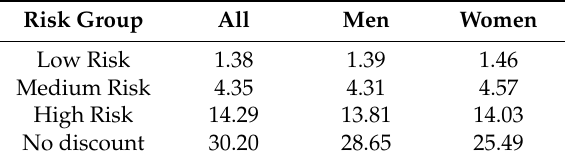
Table 7. Probability of accident during the first year of coverage